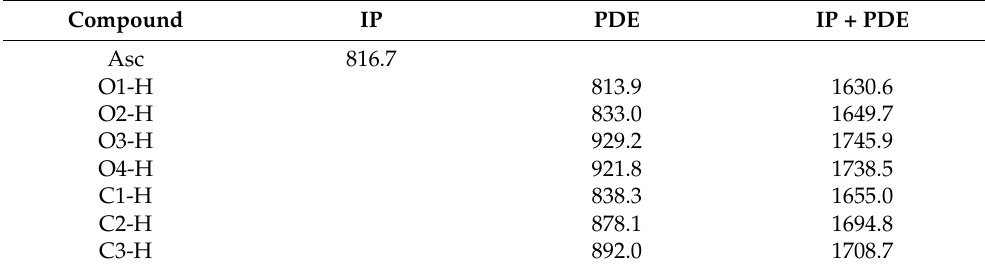
Table 5. Calculated ionization potential (IP) and proton dissociation enthalpy (PDE) values in kJ/mol for ascorbic acid (Asc) determined at the M06-2X/6-311++G(2d,2p) levels of theory in gas phase.